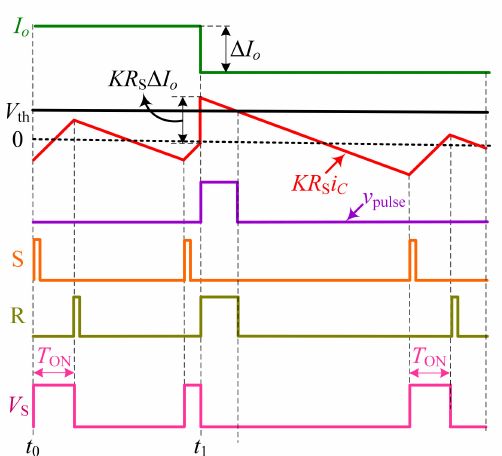
Figure 7. Key operation waveforms of the control circuit in the improved CC-COT-controlled buck converter.